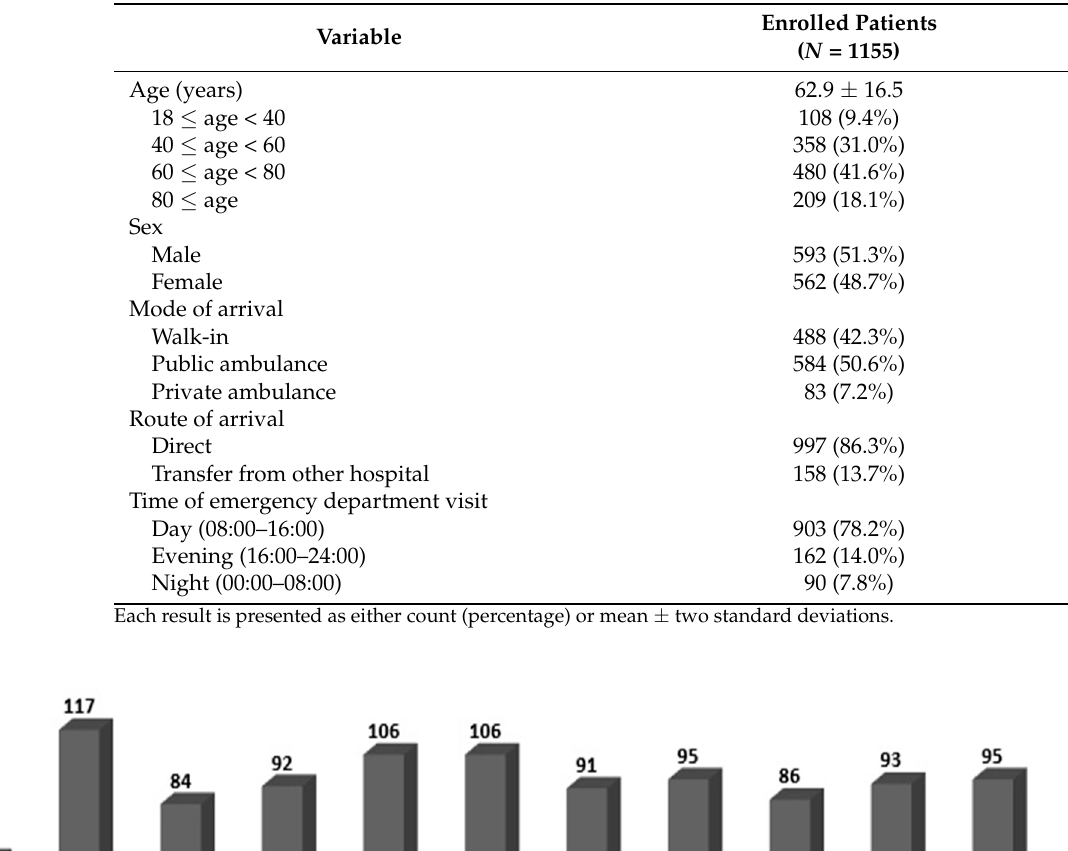
Table 1. Baseline characteristics of the enrolled patients.